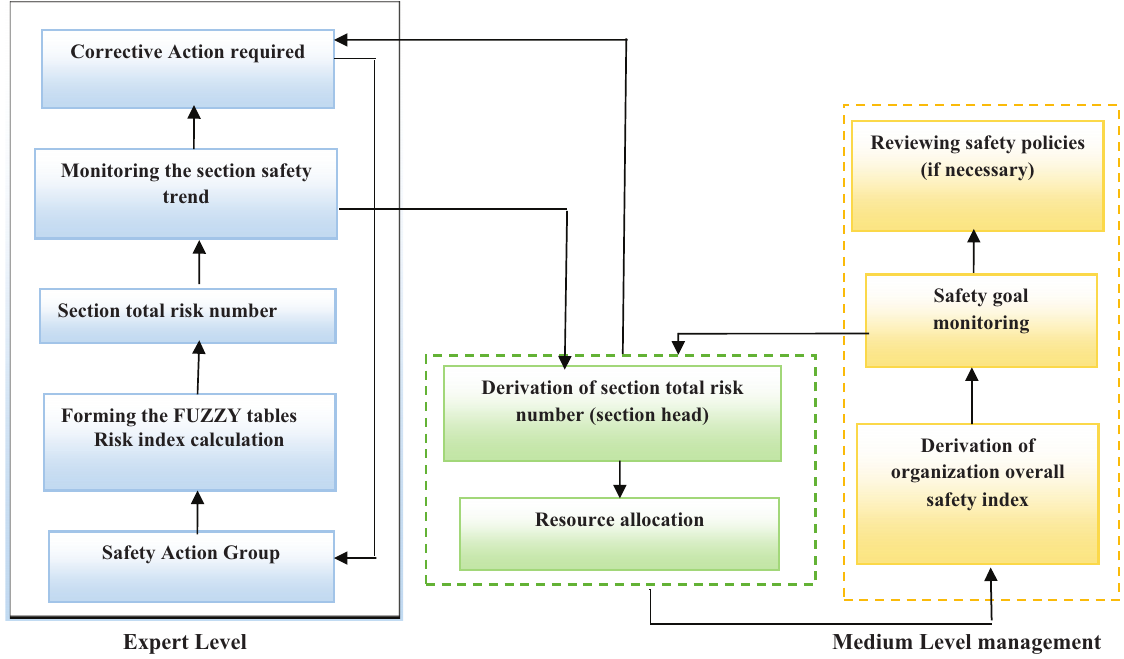
Figure 3. Building blocks (Activity assignment) of the proposed